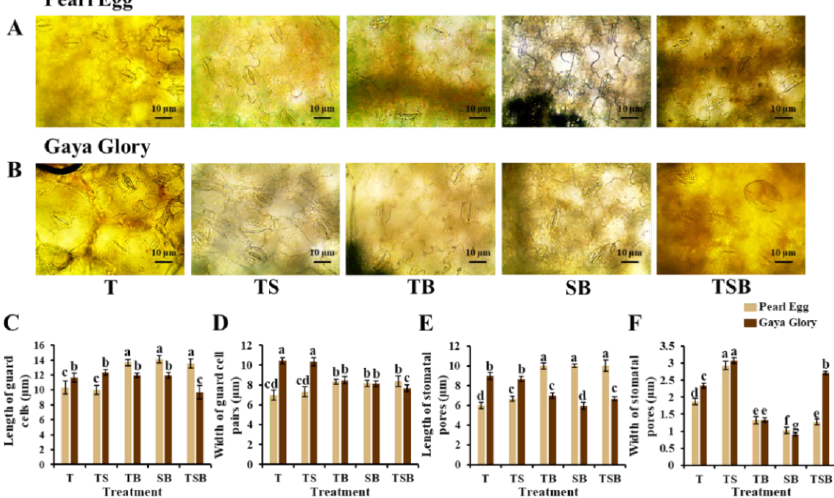
Figure 6. Changes in the stomatal morphology and parameters of chrysanthemum “Pearl Egg” and “Gaya Glory” plants as affected the different lighting direction combinations. Micrographs of stomatal morphology (40 × ) ( A , B ), length of guard cells ( C ), width of guard cell pairs ( D ), length of stomatal pores ( E ), and width of stomatal pores ( F ) of “Pearl Egg” and “Gaya Glory” as affected by the different lighting direction combinations after 45 days of cultivation. T, TS, TB, SB, and TSB, refer top (1/1), top (1/2) + side (1/2), top (1/2) + bottom (1/2), side (1/2) + bottom (1/2), and top (1/3) + side (1/3) + bottom (1/3) lighting, respectively. Vertical bars indicate the means ± standard error ( n = 6). Different lowercase letters indicate significant separations within treatments by Duncan’s multiple range test at p ≤ 0.05. Bars indicate 10 µ